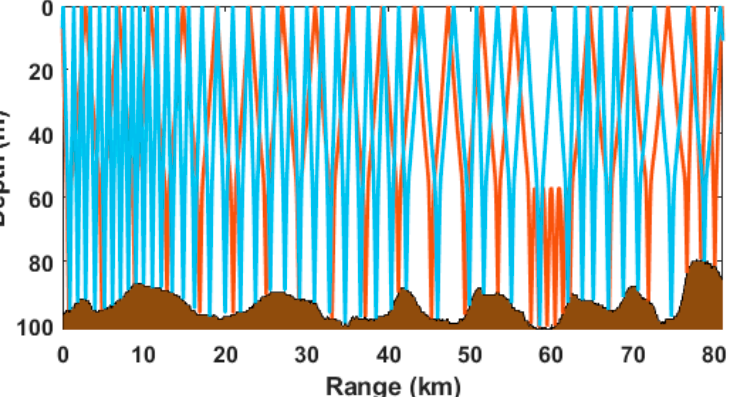
Figure 12. Eigen rays from the source to the receiver in the range of 80 km with central frequency 1000 Hz: ( a ) T1O, source depth 7 m, receiver depth 11 m; ( b ) T3O, source depth 7 m, receiver depth 11 m; and ( c ) T1O, source depth 7 m, receiver depth 71 m.